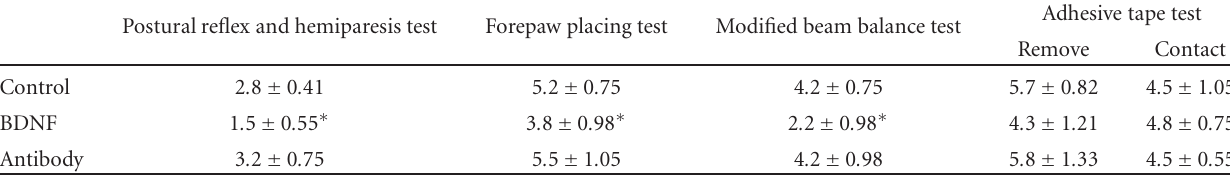
Table 3: BDNF-reducing neurologic deficits.